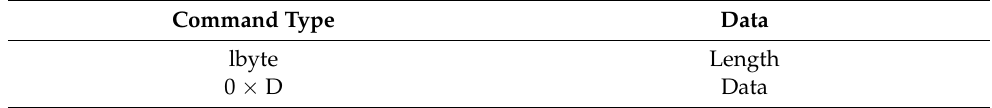
Table 6. Event return